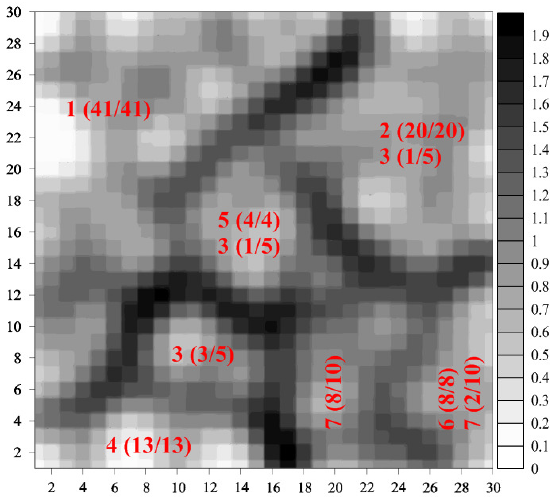
Figure 4. Gray-level U-matrix map for the visualization of the Zoo data